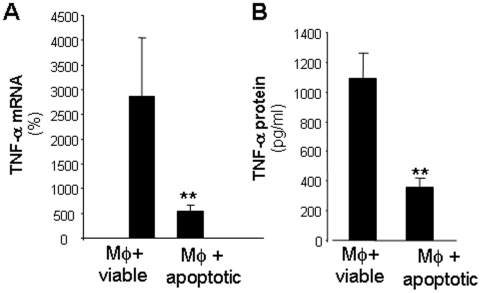
Efferocytosis of apoptotic cells by wound macrophages resulted in suppression of pro-inflammatory TNFα gene and protein expression.Following apoptotic cell clearance assay the non-phagocytosed thymocytes were removed by washing and cells were challenged with LPS (1 µg/ml) and IFNγ (10 ng/ml) for 4 h (gene expression) or 16 h (protein expression). TNFα gene (A) and protein (B) expression were measured using real-time PCR and ELISA, respectively. mRNA expression data are presented as % change compared to LPS+IFNγ non-activated control samples. Protein data is expressed as concentration of TNF-α secreted in culture media. Data are mean ±SD (n = 4); **, p<0.01 compared to macrophage cultured with viable cells.